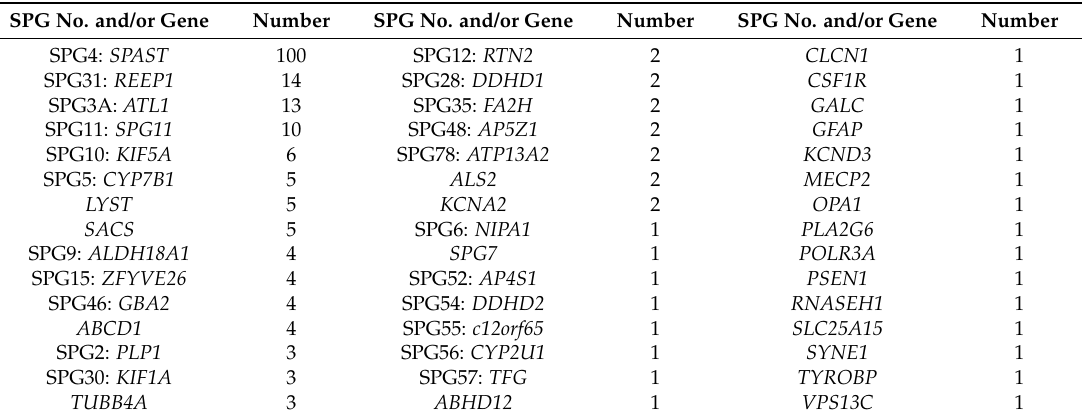
Table 1. Hereditary spastic paraplegia (HSP) genes found by the Japan Spastic Paraplegia Research Consortium (JASPAC).